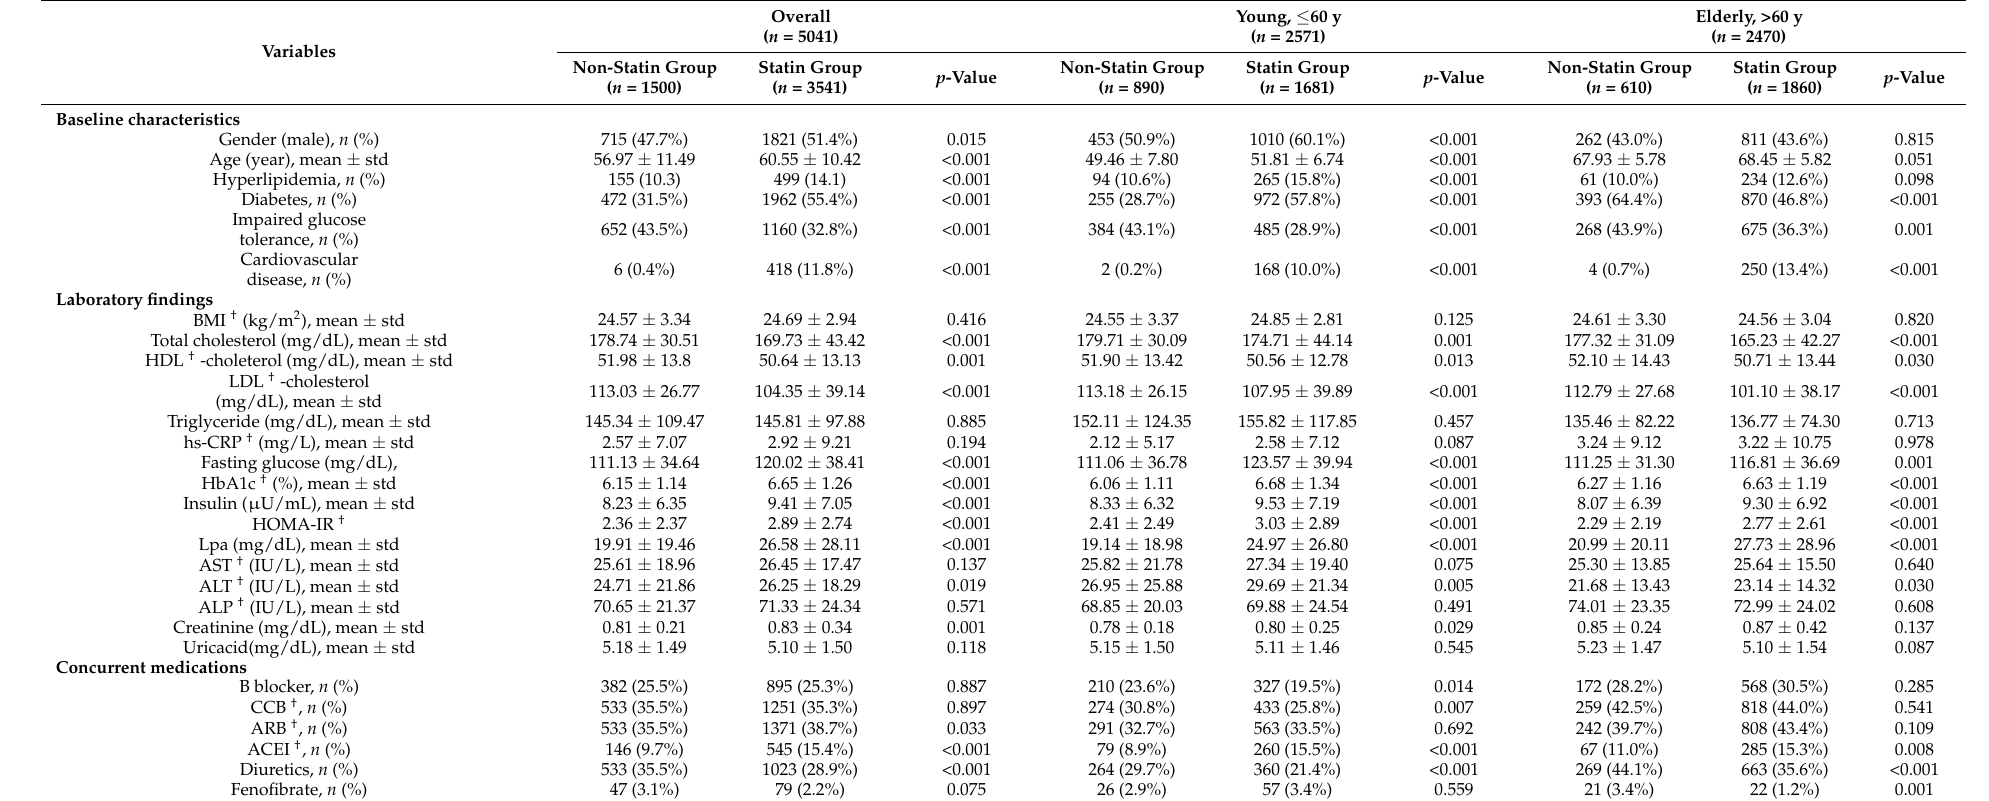
Table 1. Baselines of study patients stratified by age group before propensity score